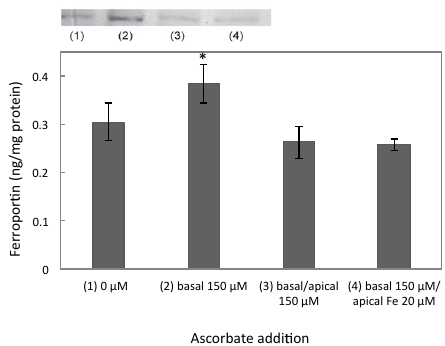
Figure 1. Sodium ascorbate (150 μ M) was added to the apical and/or basal medium of Caco-2 cells cultured on permeable Transwell ® inserts. Ferroportin protein expression was measured with ELISA. Data are means ± SD, n = 12. Significant differences from the baseline (0 μ M) are labeled with an asterisk (*). A western blot of ferroportin at the corresponding treatments is shown above the graph.